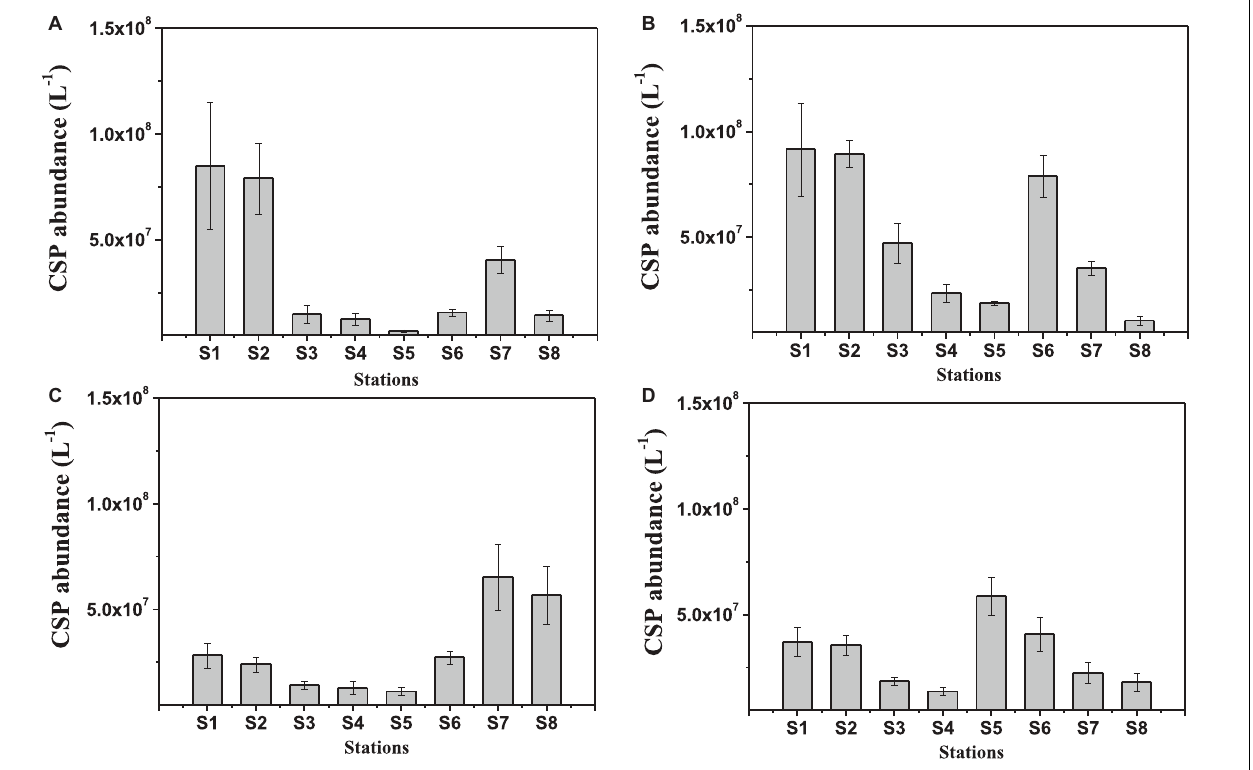
FIGURE 4 | Spatial variations of CSP abundance in the Pearl River estuary in August 2016 [ (A) surface and (B) bottom] and January 2017 [ (C) surface and (D) bottom].